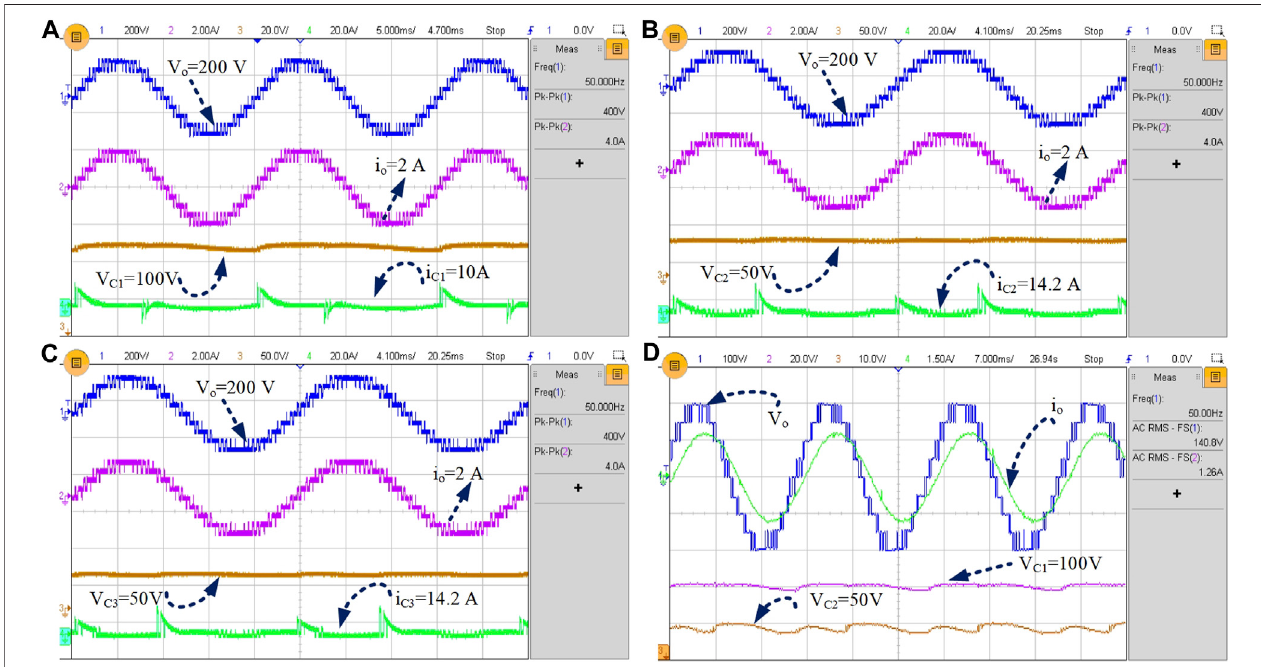
FIGURE2| Steady-stateoperatingcondition. (A) Experimentalresultsofoutputvoltage,loadcurrent,voltageacrosscapacitorsC 1 ,andcapacitorcurrenti c1 atR= 100 Ω . (B) Experimental results of the output voltage, load current, voltage across capacitors C 2 , and capacitor current i c2 at R = 100 Ω . (C) Experimental results of outputvoltage,loadcurrent,voltageacrosscapacitorsC 3 ,andcapacitorcurrenti c3 atR=100 Ω . (D) Experimentalresultsofoutputvoltage,loadcurrent,voltageacross capacitors C 1 , and C 2 at Z 2 = 100 + j100 Ω